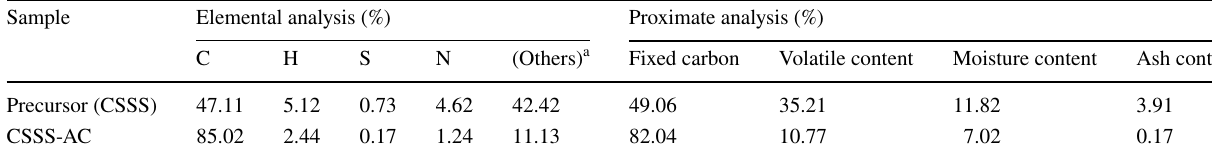
Table 6 Elemental contents and proximate analysis of the precursor (CSSS) sample and prepared activated carbon (CSSS-AC)